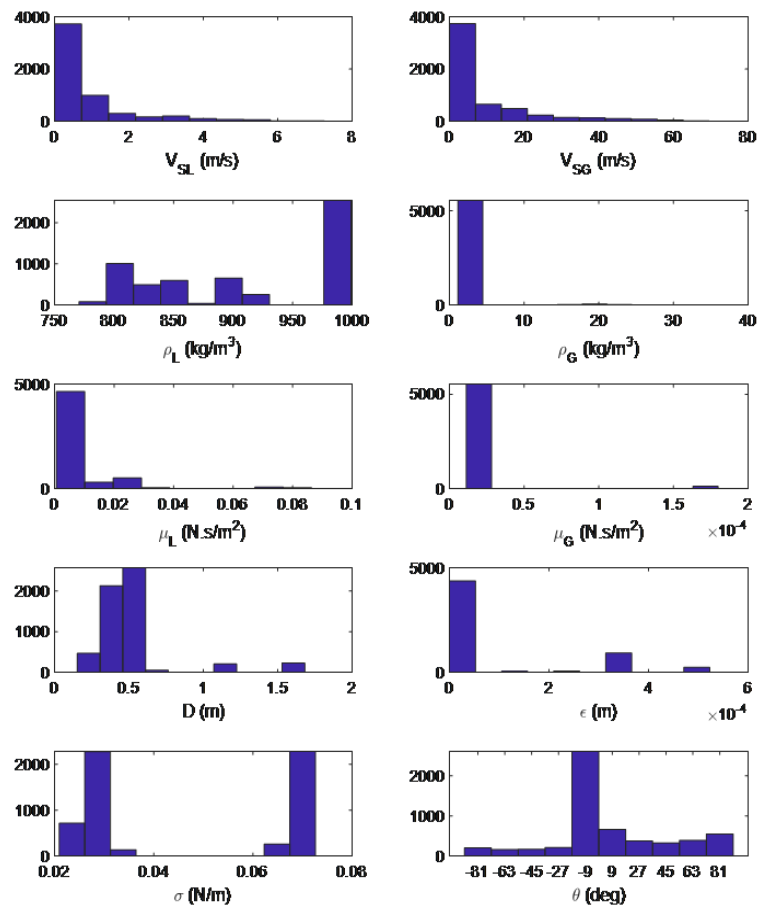
Figure 2. Stanford Multiphase Flow Database—variables distributions. Table 1. R 2 values for the steady-state multiphase flow models vs. Stanford